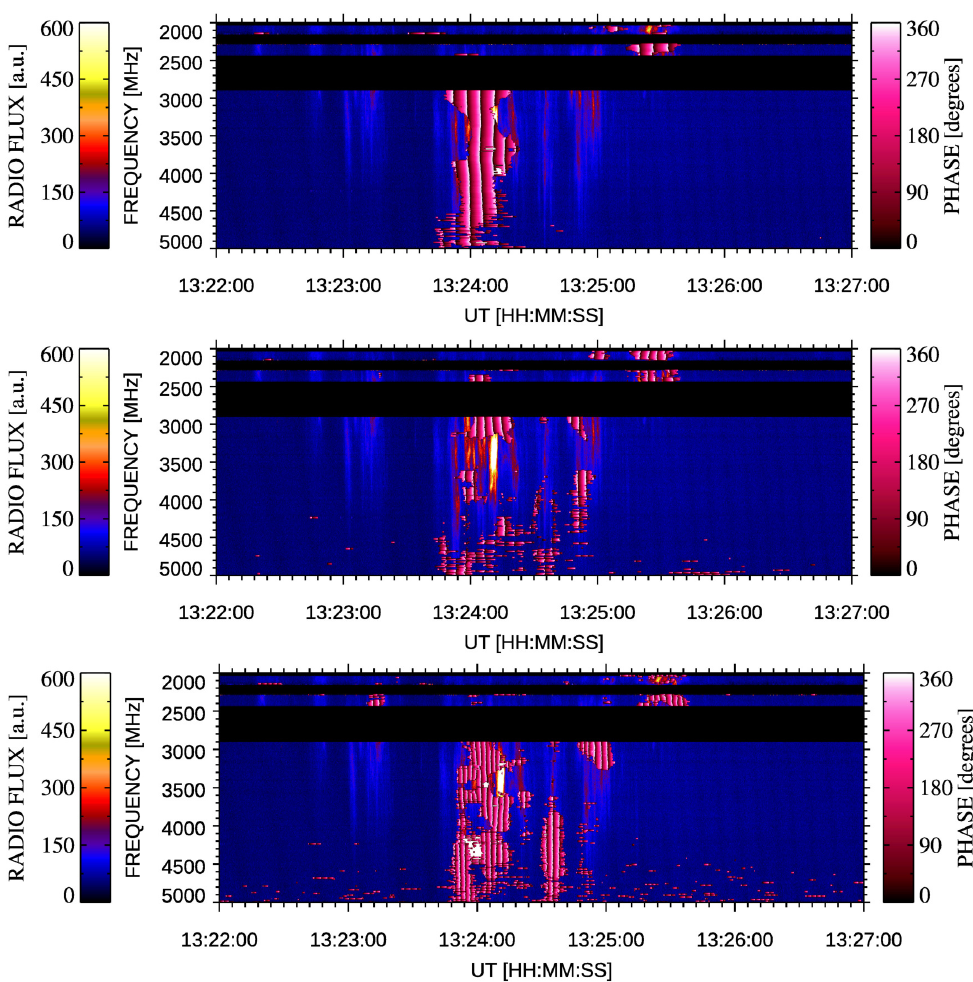
Figure 4. The type III bursts observed on 2 April 2022 in the 2000–5000MHz range in the 13:22:00– 13:27:00UT time interval: first panel (from top to bottom ): the radio spectrum observed by the Ondˇrejov radiospectrograph; second panel: histogram of the significant periods detected by the wavelet transform (cross-hatched bands, separated by the vertical lines, mark intervals of periods in bottom phase maps); and bottom four panels: the phase maps (pink areas with the black lines showing the zero phase of oscillations) overplotted on the radio spectrum for periods detected in the ranges of 7.6–11.3, 5.2–7.5, 3.4–5.1 and 1.9–3.3 s. The significance level of these phase maps is